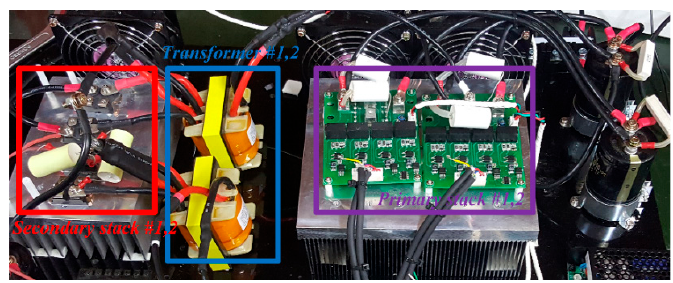
Figure 9. Photograph of the prototype.